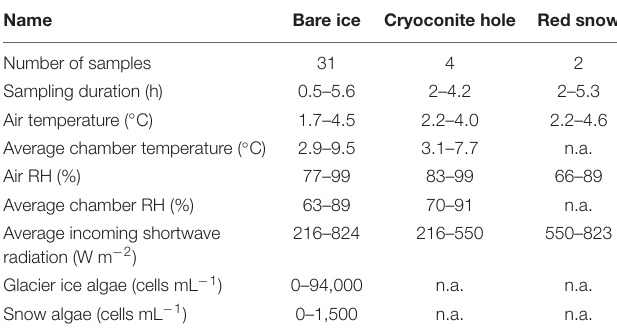
TABLE 1 | Summary of sampling conditions.